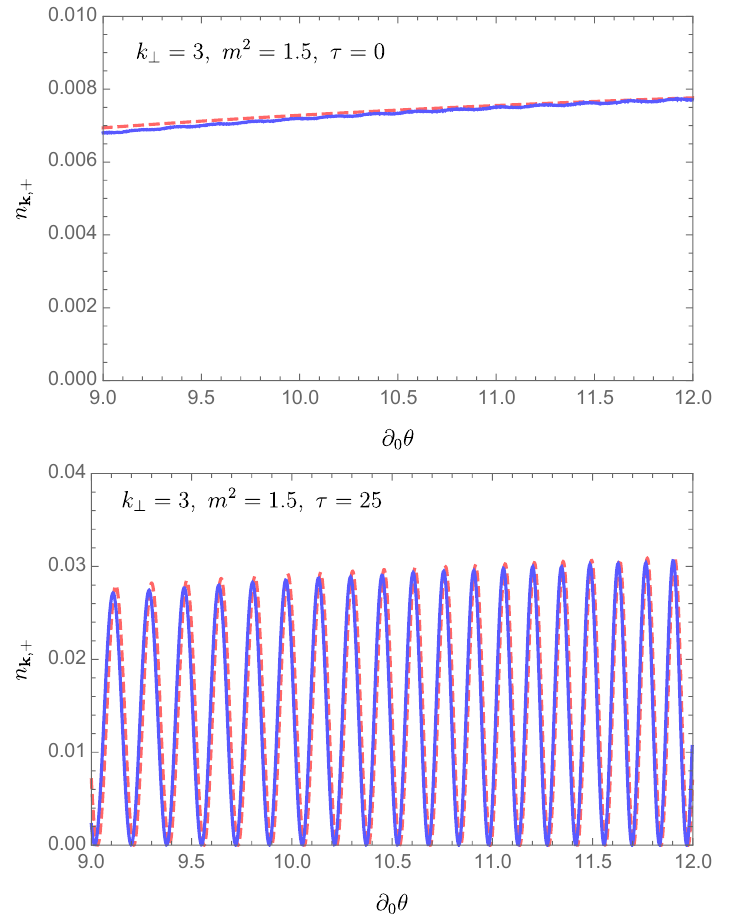
Figure 2 . n k , + is plotted fixing τ , and changing ∂ 0 θ . The blue solid line is the numerical solution of (2.33) under ∂ 2 θ = 0 , and the red dashed line is the analytical solution. In the upper panel, the 0 numerical solution at τ = 0 is shown, and the analytical solution is given by (3.17) with (3.20). In the lower panel, the numerical solution at τ = 25 is shown, and the analytical solution is given by (3.16) with (3.20) and (3.21). The parameters are expressed in the eE = 1 unit. We here note that the distribution function for the standard Schwinger effect n k = 2 exp[ − π ( m 2 + k 2 takes the tiny value 9 . 4 × 10 − 15